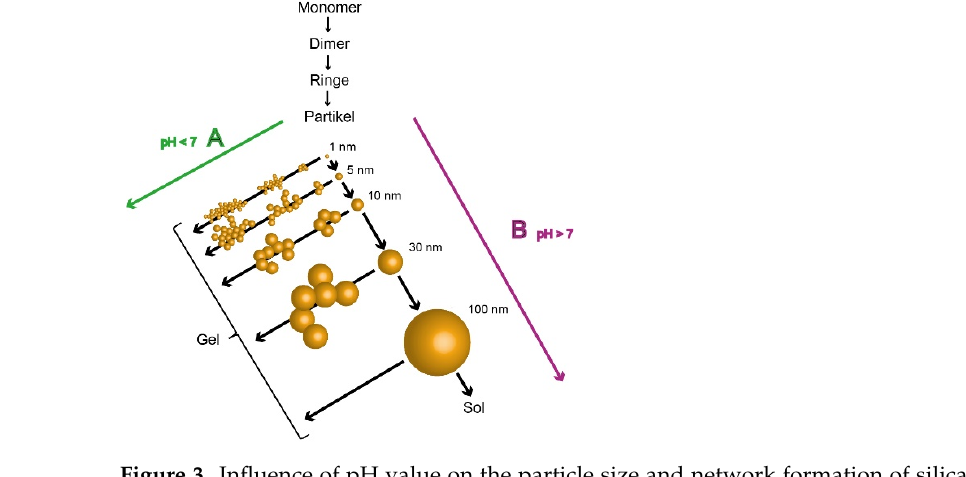
Figure 3. Influence of pH value on the particle size and network formation of silicates. Adapted from [14].